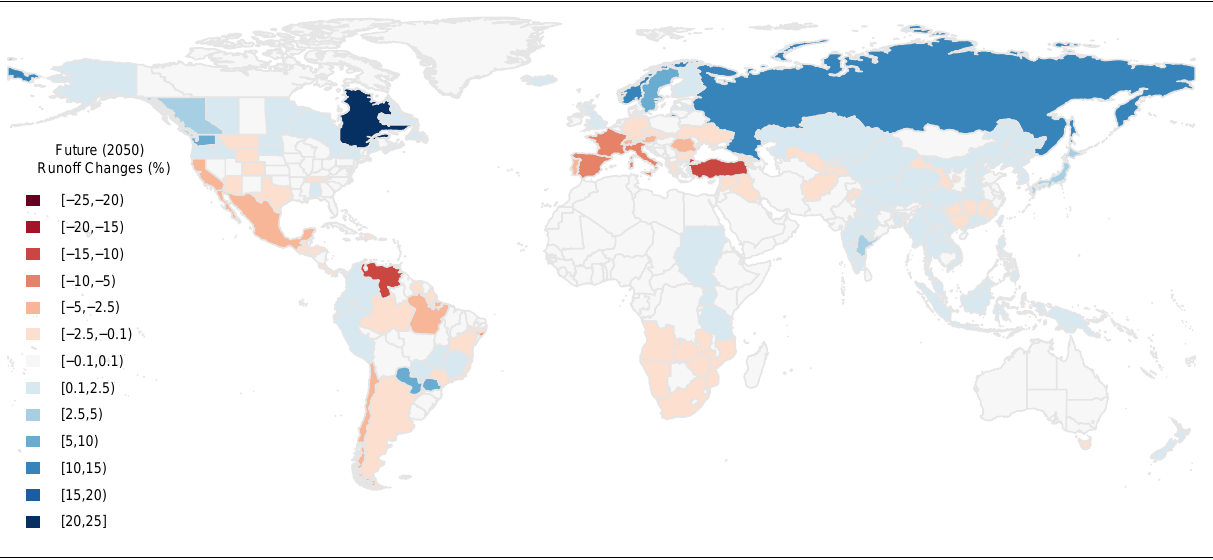
Figure 3. Future (2050) Runoff changes (%) based on 12 GCMs under A1B